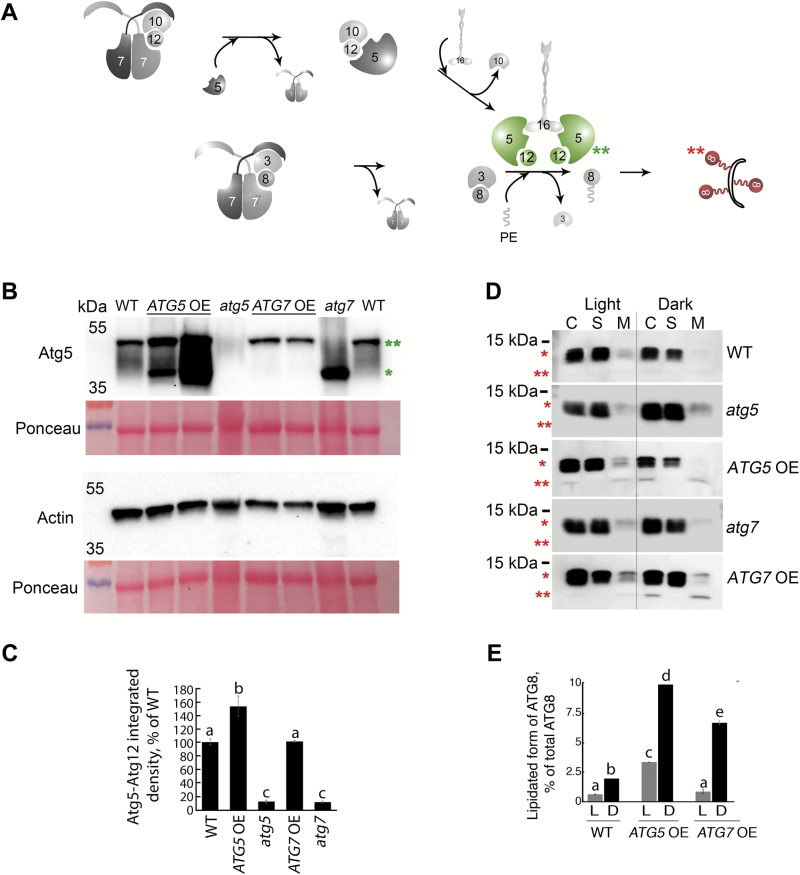
Constitutive overexpression of ATG5 or ATG7 in Arabidopsis stimulates lipidation of Atg8. (A) A schematic representation of two autophagy-related ubiquitin-like conjugation systems (Nakatogawa, 2013). Atg7 acts as an E1-like ligase by stimulating conjugation of two substrate pairs: of a ubiquitin-like protein Atg12 with its E2-like ligase, Atg10, and of a ubiquitin-like protein Atg8 with its E2-like ligase, Atg3. Atg12 is further transferred from Atg10 onto Atg5 protein in an E3-ligase-independent manner. The Atg12–Atg5 conjugate forms a complex with Atg16 and gains an E3-like ligase activity. Atg12–Atg5–Atg16 E3-like ligase stimulates conjugation of Atg8 with a phosphatidylethanolamine (PE), followed by anchoring of Atg8–PE on a membrane of a growing phagophore. Double green and double red asterisks indicate Atg12–Atg5 and Atg8–PE conjugates, respectively, also shown on the western blots on (B) and (D). (B) Atg5, but not Atg7, is a limiting component in the Atg12–Atg5 conjugation pathway. Western blot detection of Atg5 in rosette leaves of Col-0 (WT), two individual ATG5- or ATG7-overexpressing lines (ATG5 OE or ATG7 OE, respectively), and ATG5- or ATG7-knockout (atg5 or atg7, respectively) mutants. *Atg5; **Atg12–Atg5 conjugate. The experiment was repeated four times, using three individual lines of each overexpressor background. Western blot detection of actin and Ponceau staining were used as loading controls. (C) Densitometry of the Atg5–Atg12 conjugate in (B). Integrated density of bands corresponding to the Atg5–Atg12 conjugate were first normalized to the corresponding values for actin and then expressed as a percentage of the obtained value for the WT. Data represent means ±SE; n=6. Mean values denoted by the same letter do not differ significantly at P<0.001 (Student’s t-test). (D) Up-regulation of either ATG5 or ATG7 stimulates lipidation of Atg8. Seven-day-old seedlings of Col-0 (WT), atg5, ATG5 OE, atg7, and ATG7 OE genotypes were incubated for 3 d under 150 µE m–2 s–1 light, 16 h photoperiod (Light) or in the darkness (Dark). Total proteins were fractionated by ultracentrifugation and used for western blot analysis to detect free (*) and lipidated (**) forms of Atg8. C, crude extract; S, supernatant of 100000 g fraction; M, pellet of 100000 g fraction, containing membranes. (E) Densitometry of the Atg8–PE conjugate in (D). Integrated density of bands corresponding to the Atg8–PE in the crude fraction was expressed as a percentage of the integrated density of the total amount of Atg8 in the corresponding sample. Data represent means ±SE; n=6. Mean values denoted by the same letter do not differ significantly at P<0.001 (Student’s t-test). L, light; D, dark.